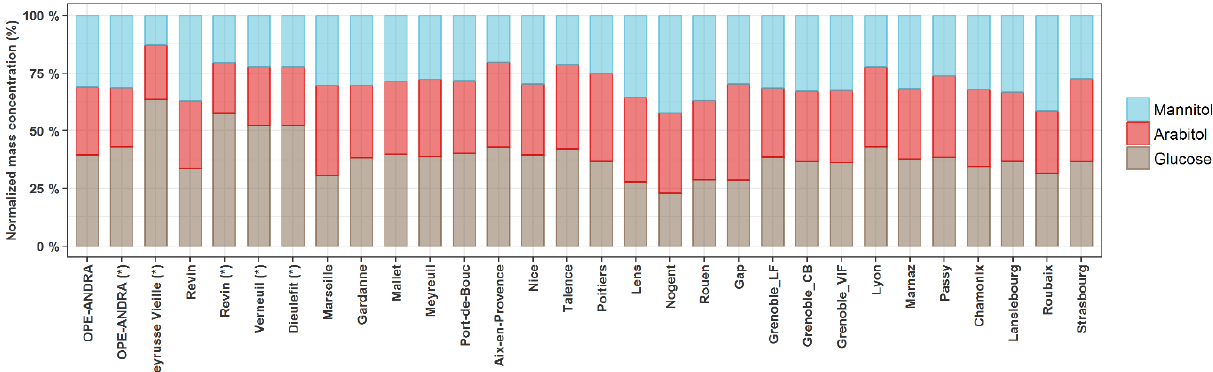
Figure 3. Average mass concentration distributions of arabitol, mannitol, and glucose. Symbol ( ∗ ) indicates PM 2 . 5 aerosol samples. Only data for warmer season (June to November), corresponding to maximal atmospheric concentration of polyols and glucose, are shown.